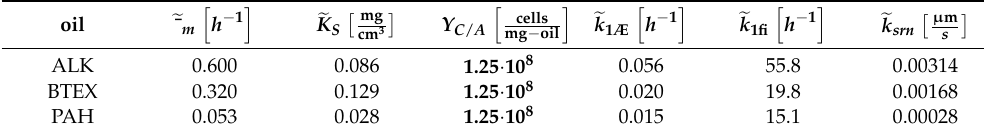
Figure 10. Impact of biodegradation and dissolution mechanisms on the temporal evolution of the dimless diameter of the oily core. For the scenario with only direct interfacial uptake (black line), the values of the parameters are: k srn = 10; Pe υ ,0 = 0; δ β ,0 = 0.0; h T = 0; Y β / A = 0. For the scenario with added dissolution (red line), the parameters are: k srn = 10; Pe υ ,0 = 100; δ β ,0 = 0.0; h T = 0; Y β / A = 0. For the scenario with added bioreaction in the biofilm (green line), the parameters are: k srn = 10; Pe υ ,0 = 100; δ β ,0 = 0.02; h T = 6; Y β / A = 0. For the scenario with added biofilm growth (blue line), the parameters are: k srn = 10; Pe υ ,0 = 100; δ β ,0 = 0.02; h T = 6; Y β / A = 1. In all scenarios, the other Table 1. Bioreaction constants ( (cid:101) k 1 υ ; (cid:101) k 1 β ; (cid:101) k srn ) based on the kinetic parameters reported by Vilc á ez et al. [32] for groups of hydrocarbons: ALK = alkanes; BTEX = monoaromatics (benzene, toluene, ethylbenzene, xylene); PAH = polyaromatics (naphthalene, fluorene, anthracene, etc.). For the calculation of the reaction constants, the cell concentrations are: (cid:101) B υ = 10 6 cells/cm 3 , (cid:101) B β = 10 9 cells/cm 3 , (cid:101) B λβ = 10 8 cells/cm 2